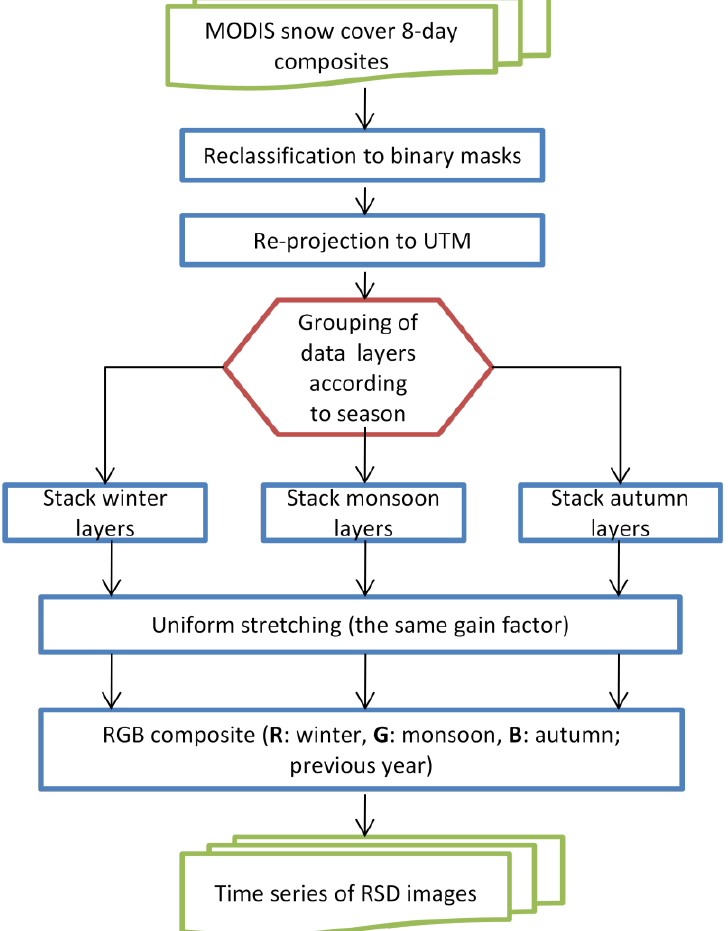
Figure 3. Flow chart of data processing of 8-day MODIS snow composites for a single